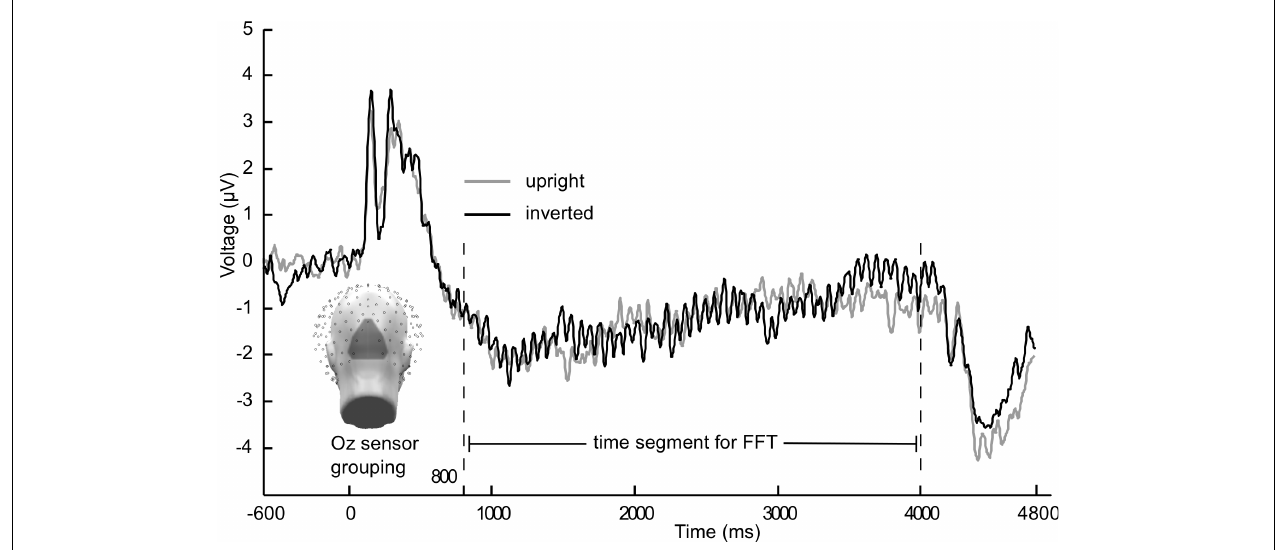
FIGURE 1 | Grand mean ( n = 21) time course of the steady-state visually evoked potential. Averaged across Oz sensor grouping over occipital pole for 15Hz flicker condition from Experiment 1. Gray lines are upright faces, black lines are inverted